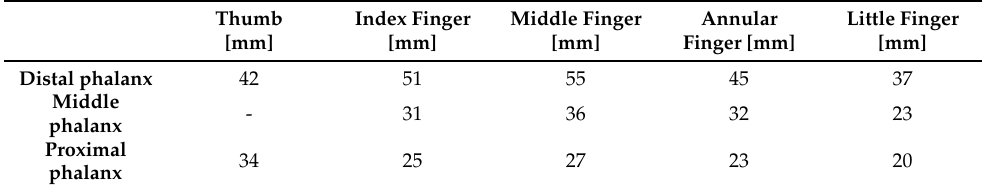
Table 3. Distal, middle, and proximal phalange measurements in millimeters for each finger of the prosthetic left hand of a man in the age range of 25–29 years. Source: Elaborated by the authors based on [44].